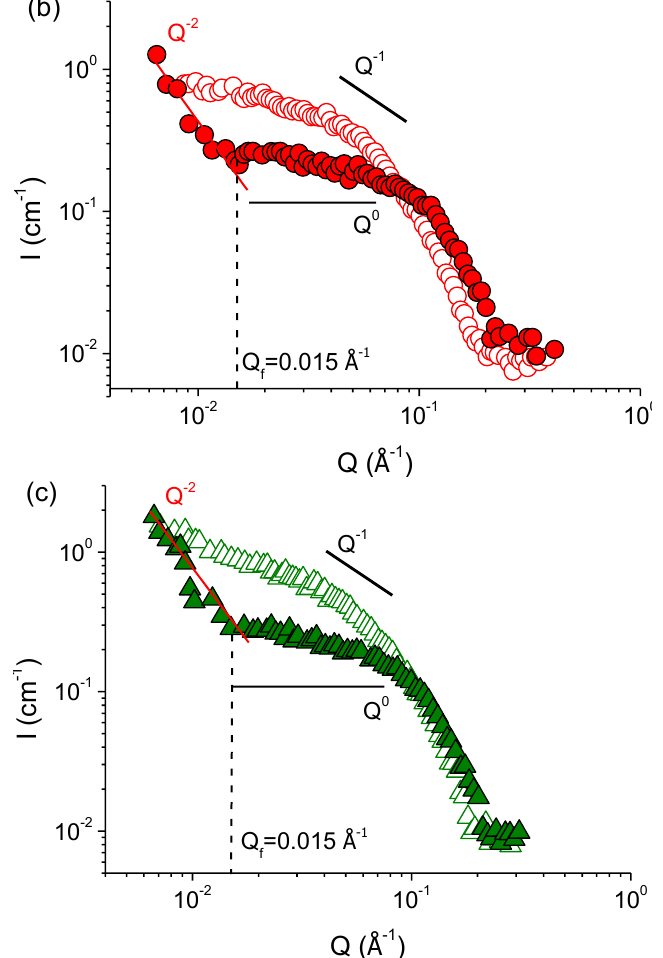
Figure 4. SANS curves of polymer-free solutions of potassium oleate (open symbols) and of saturated P4VP/potassium oleate complexes (filled symbols) in the presence of different concentrations of KCl: 67 mM ( a ), 110 mM ( b ) and 160 mM ( c ). Solvent (37 vol% D 2 O/63 vol% H 2 O at pH 11) matches the scattering from polymer. Black solid lines show slopes of the Q 0 and Q −1 dependences. Red solid line shows the slope of the curves in the low- Q range. Q f corresponds to the transition between high- Q and medium- Q scaling.